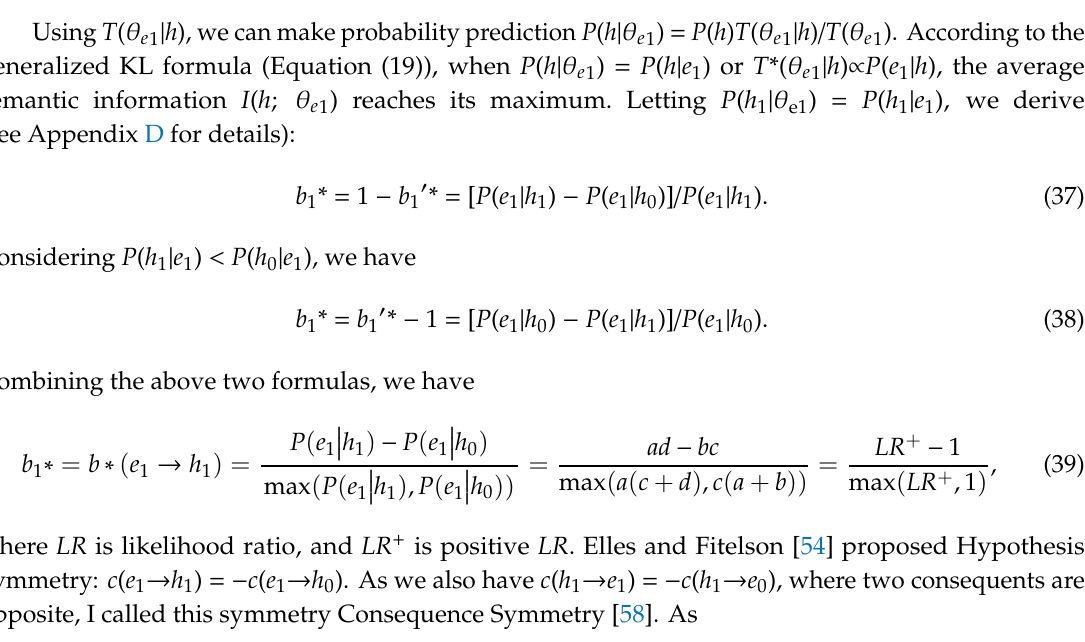
Table 3. The semantic channel ascertained by two degrees of disbelief b 1 (cid:48) and b 0 (cid:48) . e 0 (Negative) e 1 (Positive) h 1 (infected) T ( θ e 0 | h 1 ) = b 0 (cid:48) T ( θ e 1 | h 1 ) = 1 h 0 (uninfected) T ( θ e 0 | h 0 ) = 1 T ( θ e 1 | h 0 ) = b 1